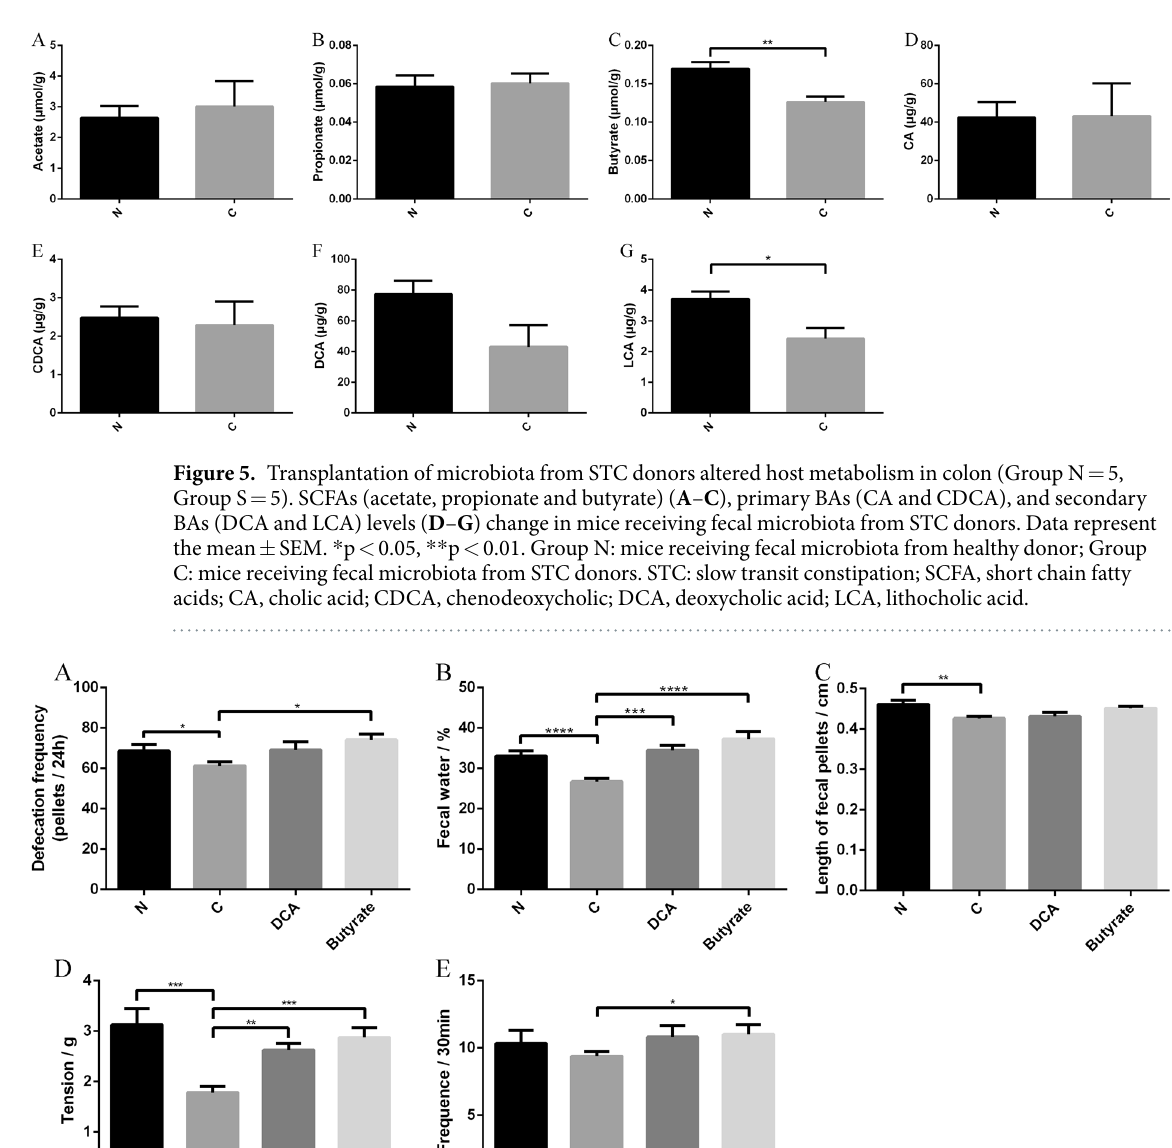
7 Scientific RepoRts | 7: 441 | DOI:10.1038/s41598-017-00612-y